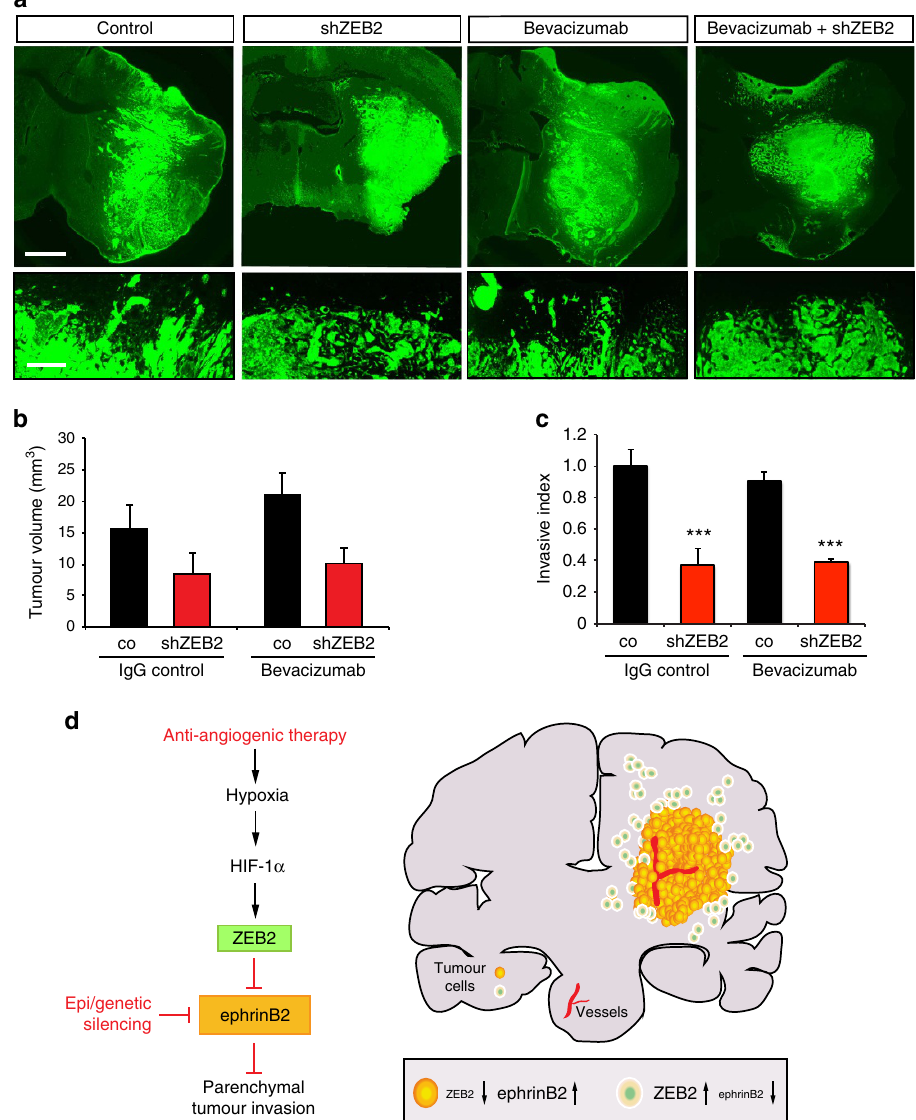
Figure 8 | ZEB2 blockade inhibits the growth and invasion of bevacizumab-resistant LN229 glioblastoma xenografts. ( a , b ) ZEB2 silencing impairs tumour growth of LN229 glioblastoma xenografts. Fluorescence micrographs of intracranial tumour xenografts of GFP-expressing polyclonal